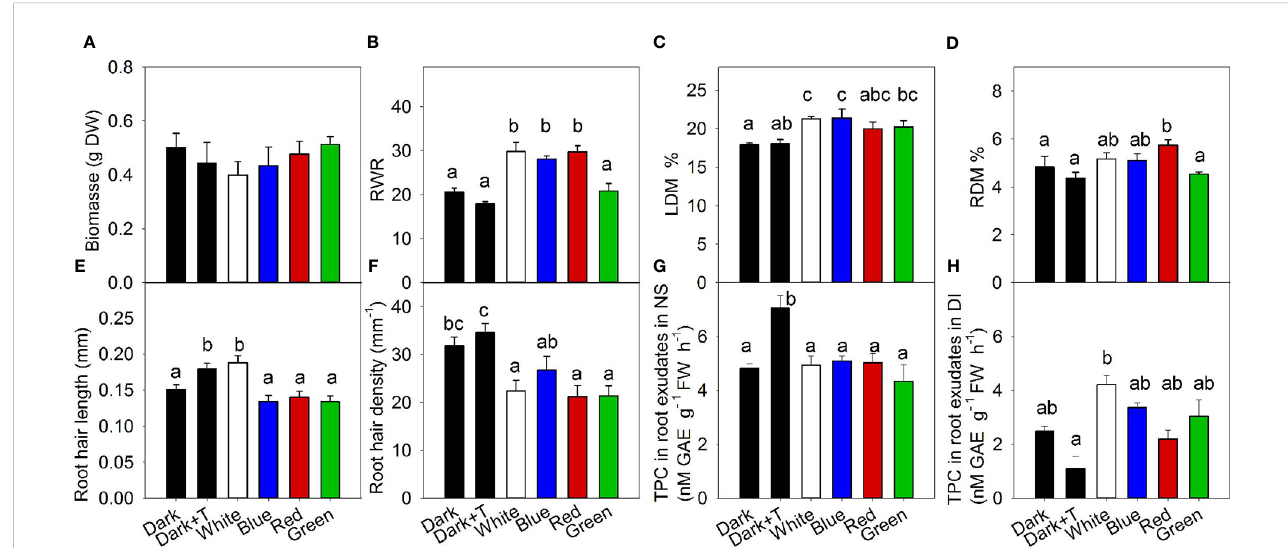
FIGURE 3 The effects of the exposure of Hypericum perforatum roots to white, blue, red, and green light and to a higher nutrient solution temperature (35.5°C) on plant biomass (A) , root weight ratio (RWR) (B) , leaf dry matter content (LDM) (C) , root dry matter content (RDM) (D) , root hair length (E) , root hair density (F) , and amount of total phenolic compounds (TPC) in root exudates during plant cultivation in nutrient solution (G) and amount of TPC released into distilled water shortly before the fi nal sampling (H) . Differences between means with different letters are statistically signi fi cant at p<0.05 ( n=4 ). Roots of H. perforatum were exposed to the light at 30 days after sowing (DAS). The fi nal plant samples were collected at 47